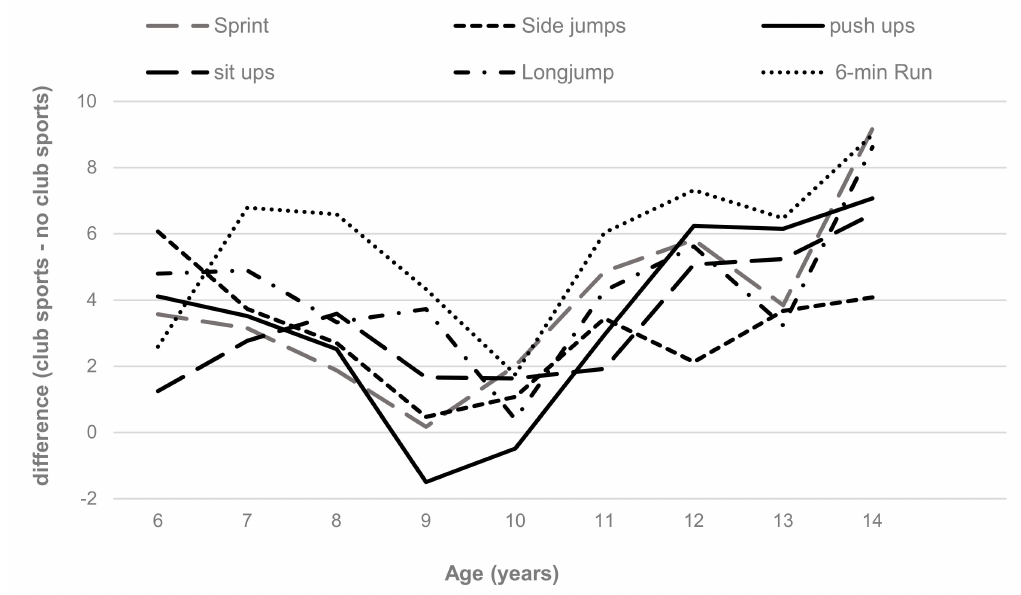
Figure 3. Mean di ff erence in age- and sex-standardized scores between club sports and non-club sports participants on individual fitness tasks across the ages 6–14